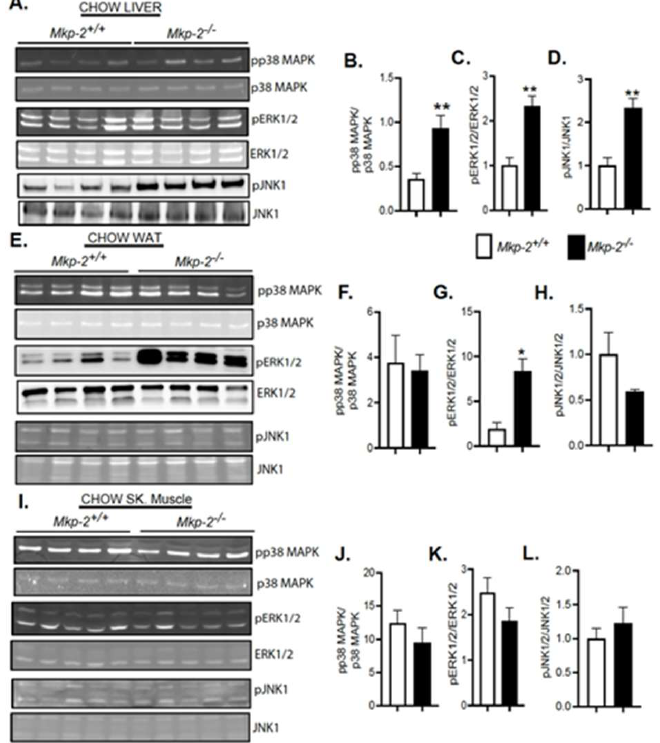
Figure 2. Enhanced MAPK Phosphorylation in Chow- and HFD-fed MKP-2-Deficient Mice. Liver tissue lysates from liver, skeletal muscle, and white adipose tissue lysates from chow- and HFD-fed mice. Mkp-2 +/+ and Mkp-2 − / − were analyzed by immunoblotting (N = 4–6). Representative immunoblots were quantitated by densitometry for phospho-p38 MAPK/p38 (( A ) upper panel and ( B )), phospho-JNK1/2/JNK1/2 (( A ) lower panel and ( C )), and phospho-ERK1/2ERK1/2 (( A ) middle panel ( D )) in chow liver; phospho-p38 MAPK/p38 MAPK (( E ) upper panel and ( F )), phospho-ERK1/2ERK1/2 (( E ) middle panel ( G )), and phospho-JNK1/2/JNK1/2 (( E ) lower panel and ( H )) in chow WAT; phospho-p38 MAPK/p38 MAPK (( I ) upper panel and ( J )), phospho- ERK1/2ERK1/2 (( I ) middle panel ( K )), and phospho-JNK1/2/JNK1/2 (( I ) lower panel and ( L )) in chow skeletal muscle. Results represent the mean ± SEM; * p < 0.05, ** p < 0.01 as determined by Student’s t